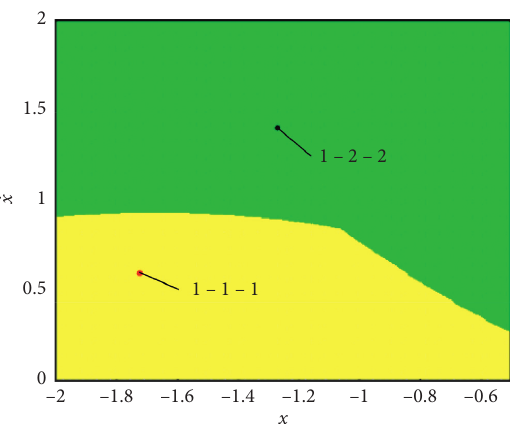
Figure 7: The attraction domain on the phase-fixing surface Σ